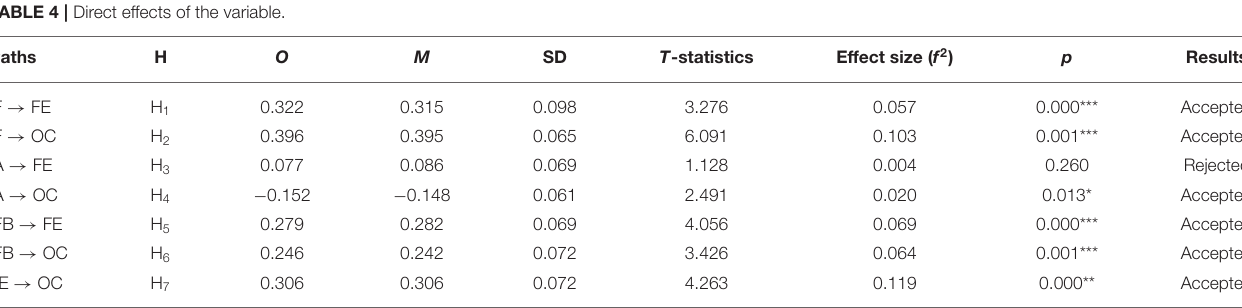
TABLE 4 | Direct effects of the